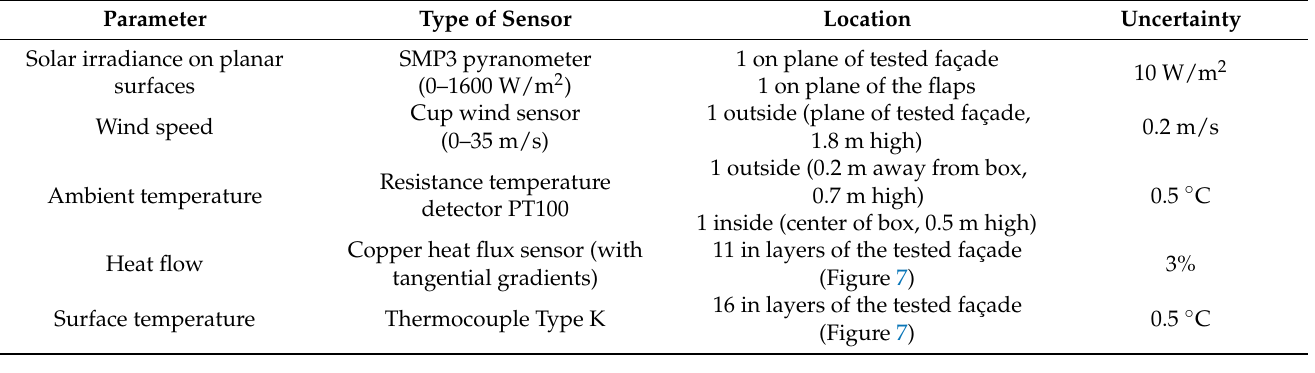
Table 4. List of installed sensors on the test bench.